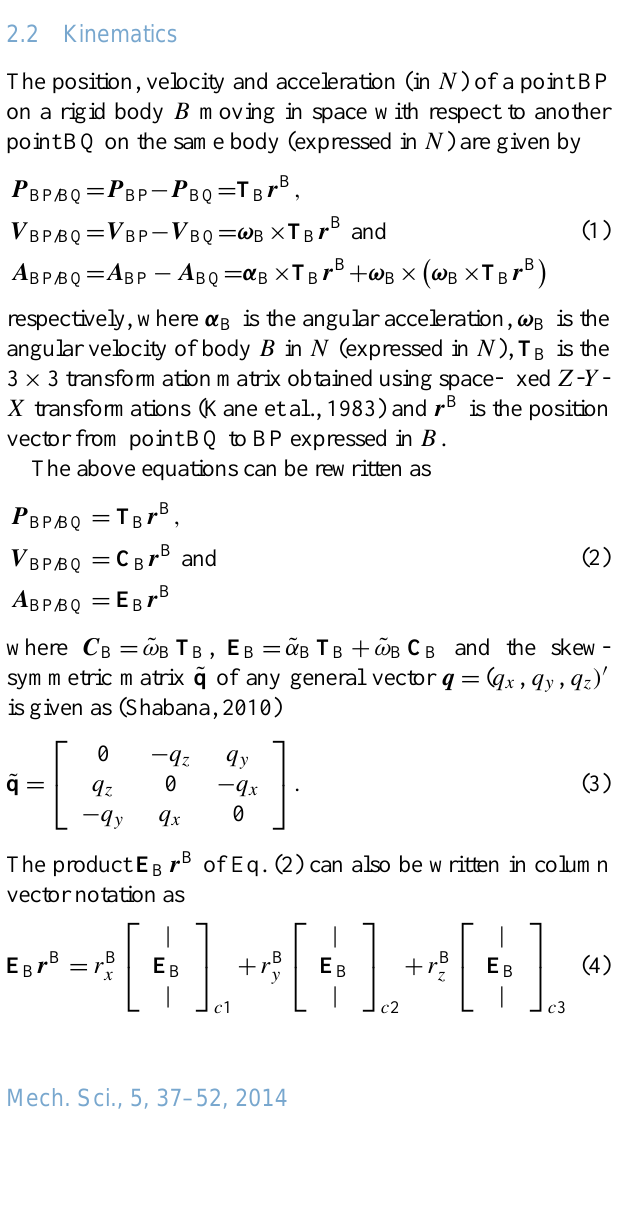
Figure 2. FROS with y axis (of the coordinate system fixed to the foot) lying along the line joining the ankle and the COM of the foot.